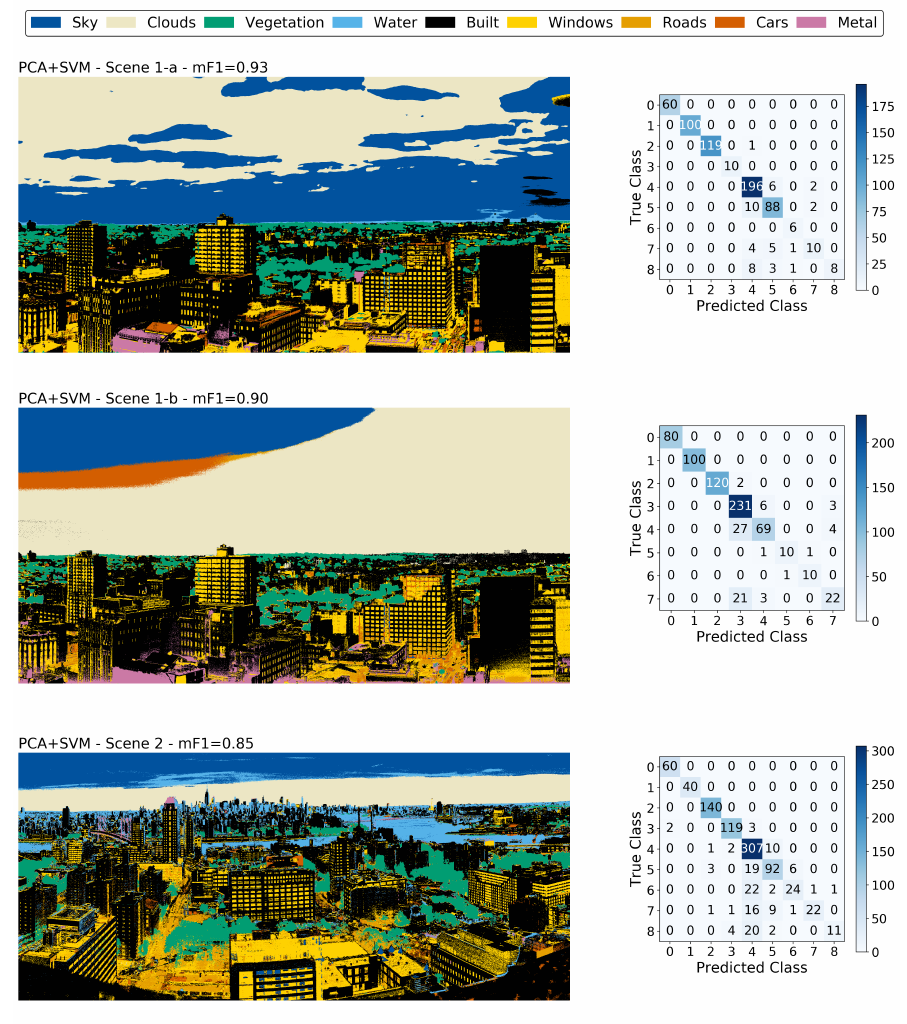
Figure A6. ( left ) Segmentation maps from applying PCA to Scene 1-a ( top ), Scene 1-b ( middle ), and Scene 2 ( bottom ), then using SVM to classify the pixels. ( right ) Confusion matrices from the testing sets of each